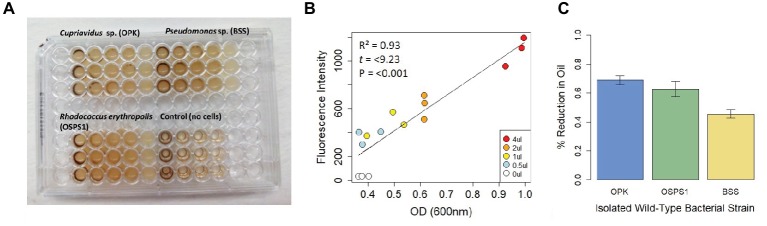
Design and performance of a fluorescence-based assay to detect bacteria that degrade crude oil. (A) Assay of three bacteria isolated from Shell Pond after 3 days of exposure to crude oil (concentrations ranging from 0.125–2%) in minimal salt media (MSM). Consumption of crude oil can be seen in wells with bacteria. (B) Correlation between fluorescence intensity (FI) and optical density (OD). Each point in the plot represents the treatments from 2A (decreasing from 4 to 0.5 μl per well, for a concentration of 2–0.125% crude oil per 200 μl well volume) at T
0. Correlation between FI and OD for each treatment was >0.9 at T
0, demonstrating the replicability of this assay. (C) Amount of crude oil consumed by each bacterial strain when grown in 2% crude oil.